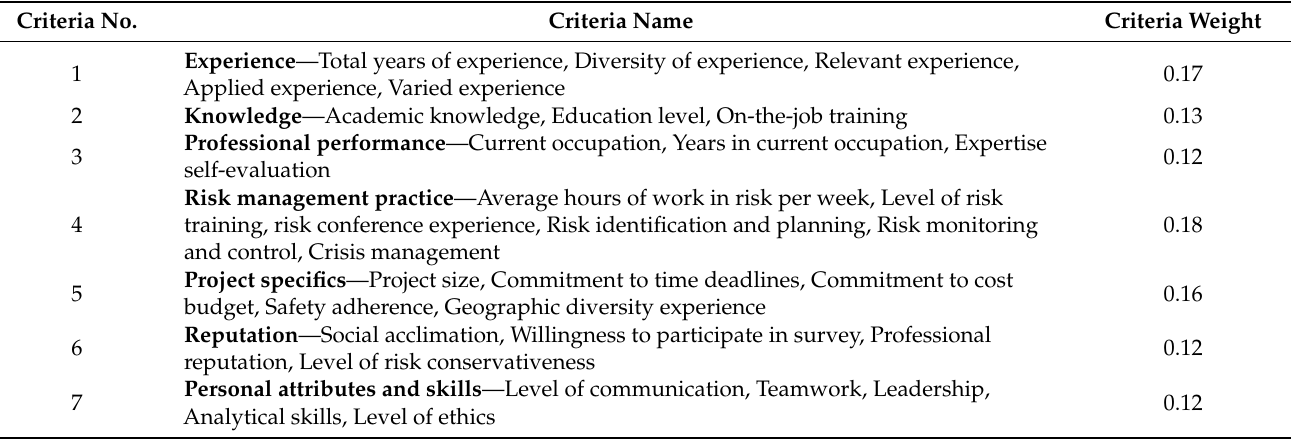
Table 1. Expertise level of the experts in risk management (list of criteria names adapted from reference [52]). Criteria No. Criteria Name Criteria